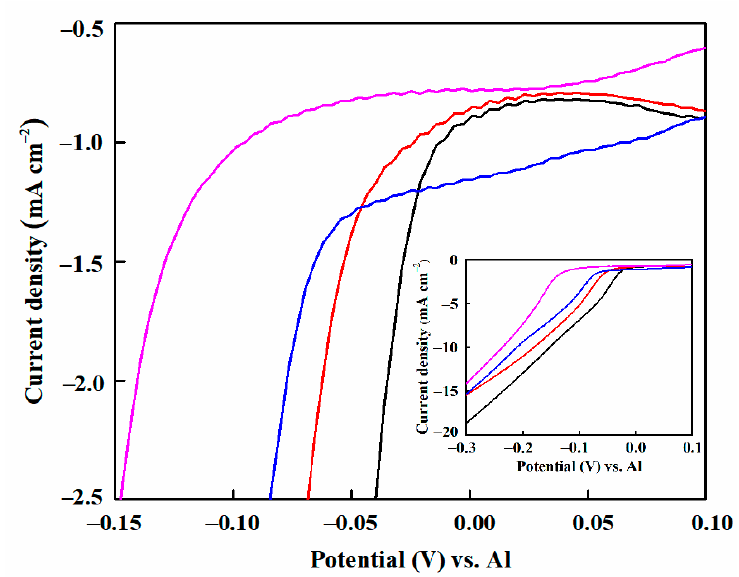
Figure 7. Cathodic polarization curves for electrodeposition of EMIC-AlCl 3 -MnCl 2 containing no (black line), 6 mmol · L − 1 4-hydroxypyridine (red line), 4-picolinic acid (blue line), and 4-cyanopyridine (magenta line) at 303 K on the Cu substrate. Scan rate: 10 mV s − 1 . The inset shows the cathodic polarization curves corresponding to a wider range of horizontal and vertical coordinates.